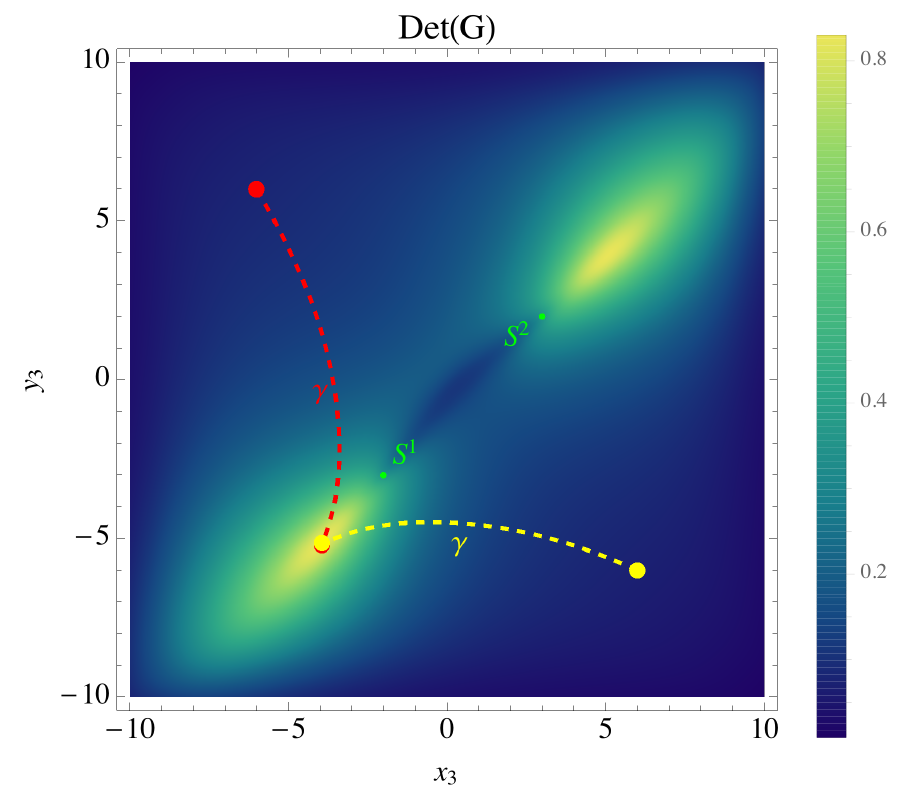
Figure 6. Contour plot of det ( G ) , for G given by (14), for the case of three sensors, where S 1 is fixed at ( − 2, − 2 ) , and S 2 at ( 2,2 ) (red dot). Brighter shades indicate a greater value of det ( G ) ; det ( G ) is maximum at ( − 1, − 5.5 ) . The third sensor is allowed to move. The geodesic path linking the initial and final positions of S 3 starting at ( 6, − 6 ) (yellow dot) is shown by the dashed yellow curve, while the dashed red curve shows another geodesic path linking ( − 6, − 7 ) (red dot) to the D-optimal location ( − 1, − 5.5 ) . The actual positions of the sensors are raised above Ω by a distance z i